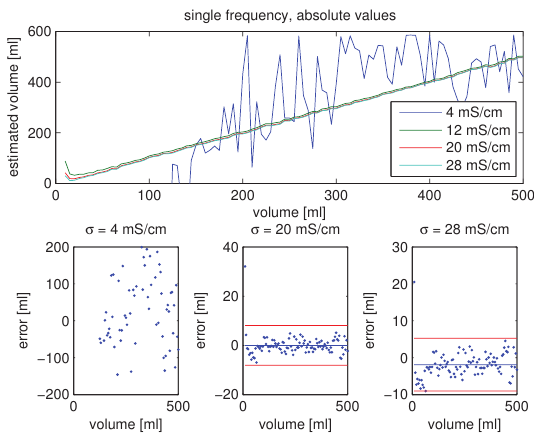
Fig.8: In-silico results for single-frequency variant using absolute values: The method is unreliable for urine conductivities in the range of surrounding tissue impedances (4mS/cm in this case).